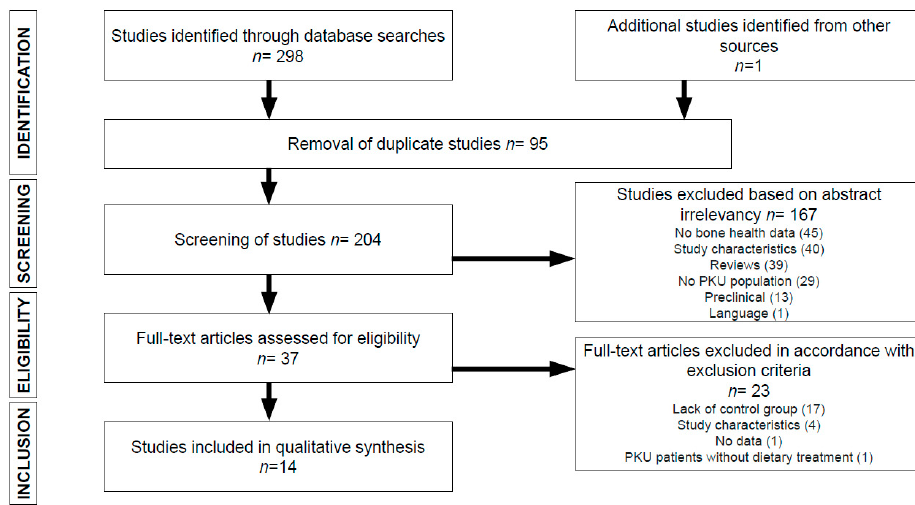
Figure 1. Flowchart depicting literature search process. PKU, phenylketonuria.